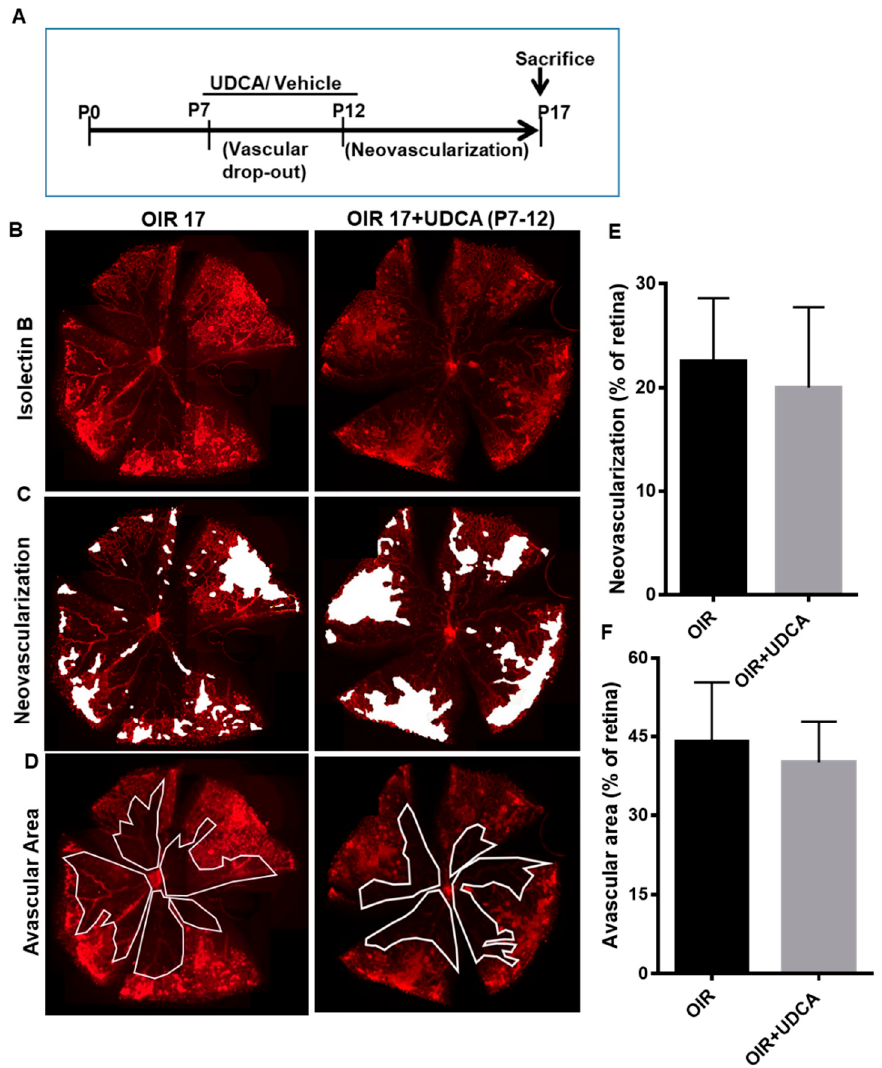
Figure 2. E ff ect of UDCA treatment during the hyperoxic phase on pathological neovascularization in OIR mice. ( A ) Schematic diagram depicting mouse OIR experimental model and UDCA (50 mg / kg) treatment from P7 to P12. ( B ) Representative flat-mounted retinas of OIR mice at P17 and OIR mice treated with 50 mg / kg UDCA, from P7 to P12, stained with isolectin B4 to identify ( C ) areas of neovascularization (white spots) and ( D ) avascular area (white lines). Histograms representing the results of morphometric analysis of retinal flat mounts measuring ( E ) area of neovascularization and ( F ) avascular area. Values are mean ± S.D. ( n = 6 retinas per group).